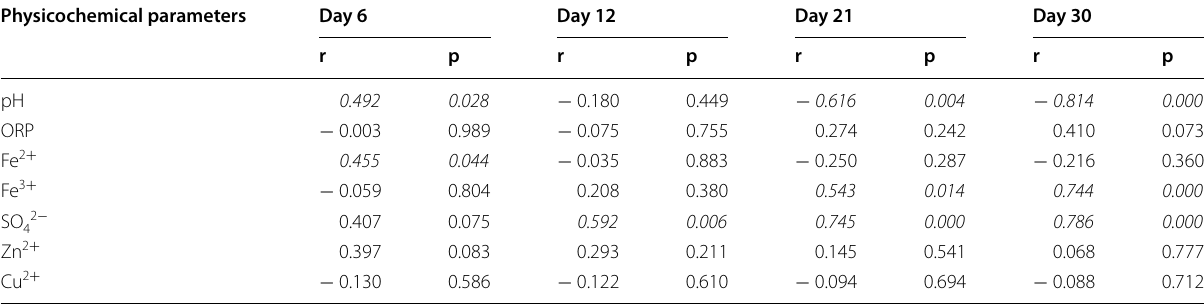
Significant differences ( p < 0.05) were indicated in italics